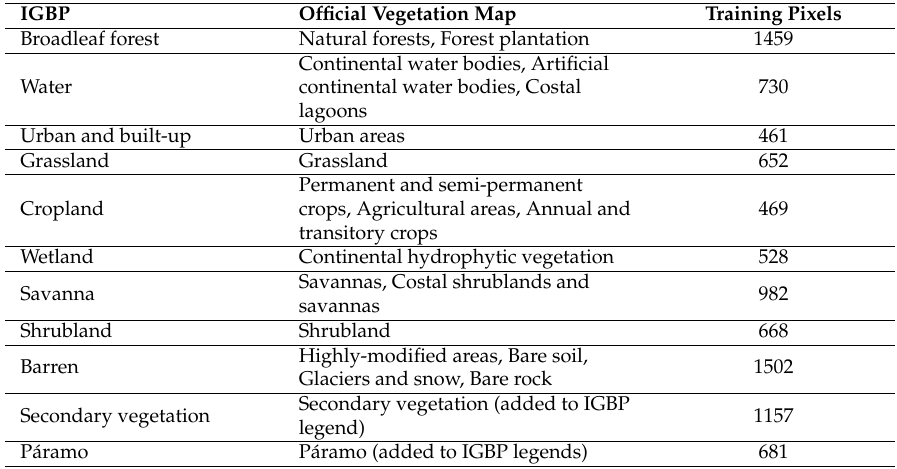
Table 2. Aggregation of the national vegetation map [46] with 18 classes to nine IGBP classes and adding secondary vegetation and páramo. Training samples were derived from the national vegetation map and visual interpretation of high spatial resolution satellite